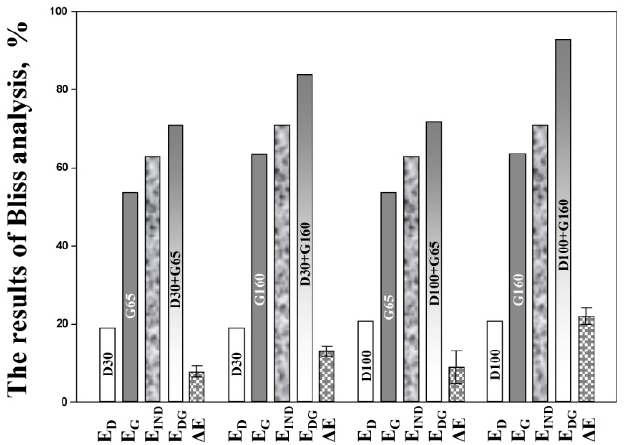
Figure 2. The results of Bliss independence drug interaction analysis of daptomycin and gentamicin combinations in an in vitro dynamic model.